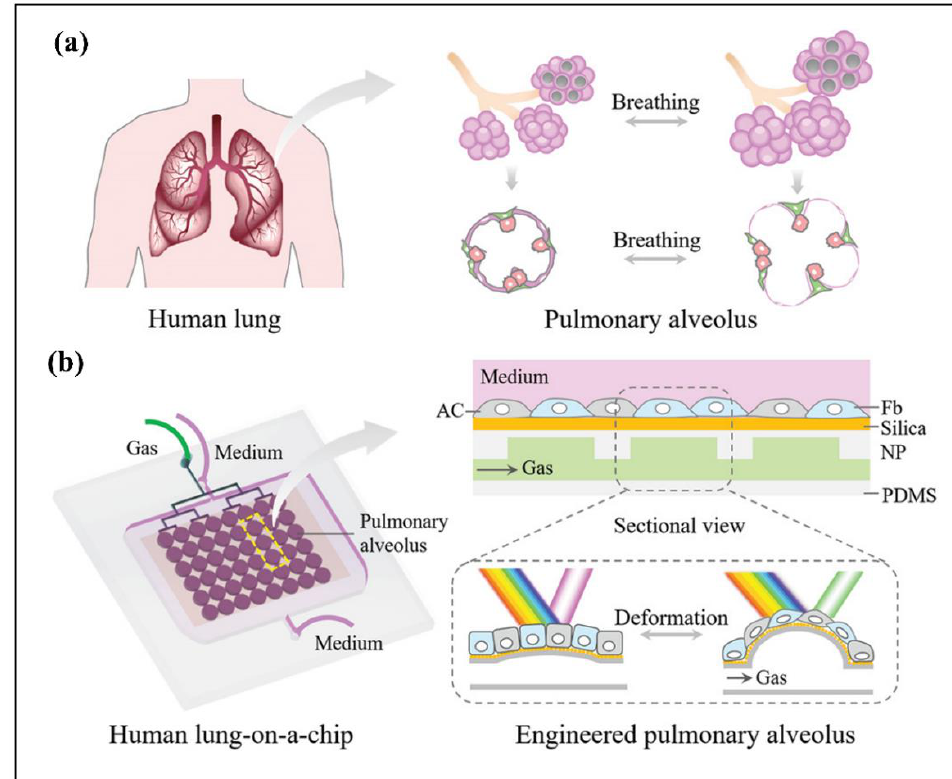
Figure 18. Schematic of lung-on-a-chip platform presented by Zhu et al. to develop favourable biomimetic breathing human lung with microphysiological breathing monitoring. ( a ) Figure of pulmonary alveolus while breathing. ( b ) Design of the developed breathing human‑lung‑on‑a‑chip device consisting of an array of pulmonary‑alveolus‑like structures. Rhythmic stretch during breathing was mimicked by cyclic airflow. Utilization of structural colours was enhanced to visualize breathing process. Fb = fibrinogen; NP = nanoparticle; AC = alveolar cell. Reprinted with permission from ref. [390], Copyright 2022, Wiley Online Library.